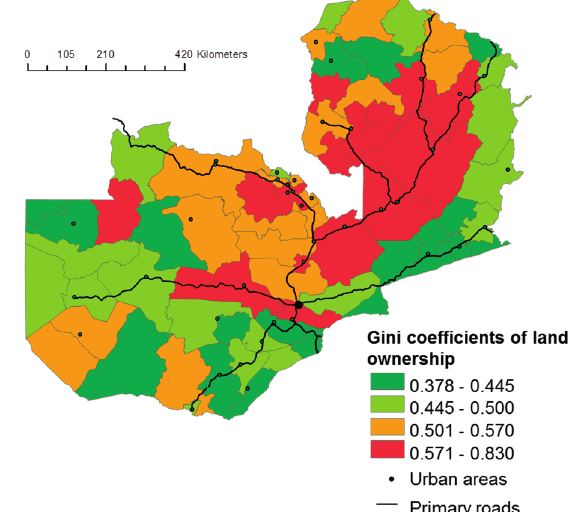
Figure 3. Gini Coefficient of small and medium-scale land holdings by district, 2009. Source: CFS